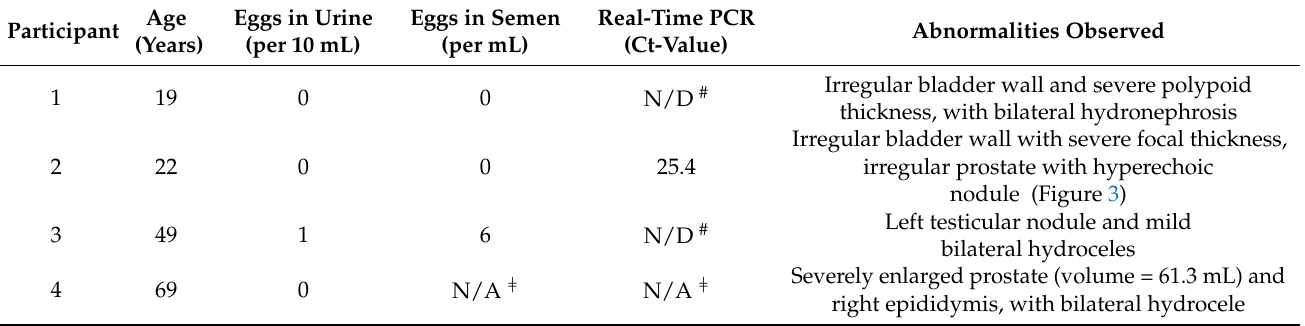
Table 3. Abnormalities observed in participants with at least 2 GU organs affected at baseline.